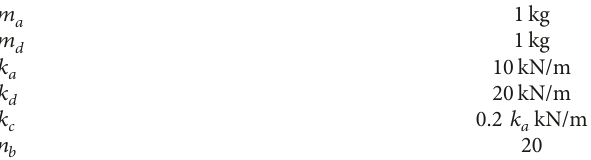
Table 1: The properties of the bladed disk.